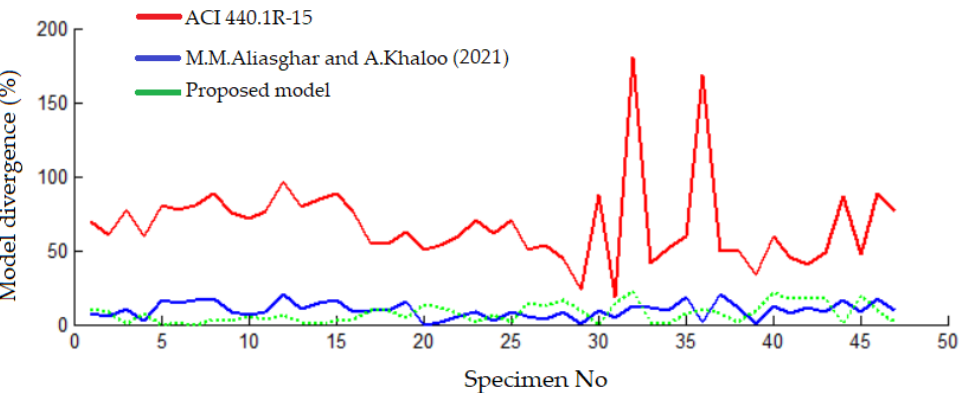
Figure 21. EFS prediction divergence of the present model compared to M.M Aliasghar and A Khaloo (2021) and ACI440.1R.15 models.